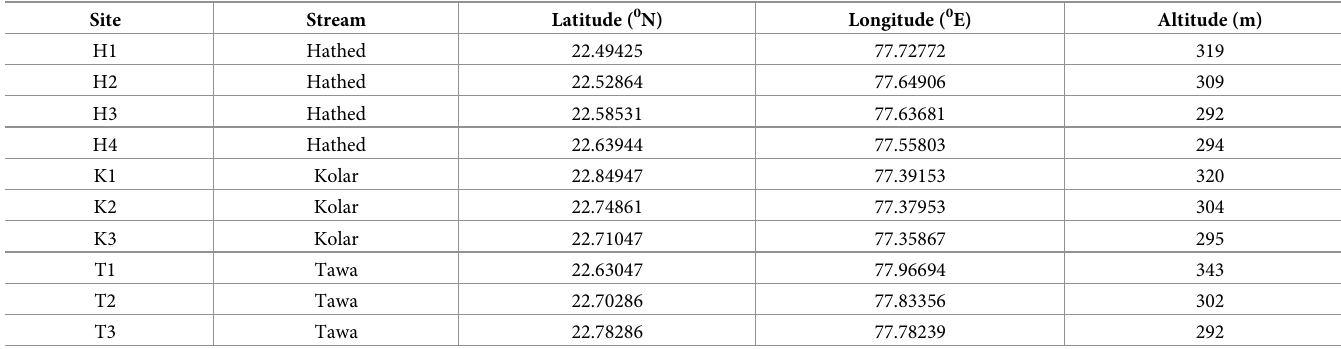
Table 1. Site names, location and description for Madhya Pradesh.